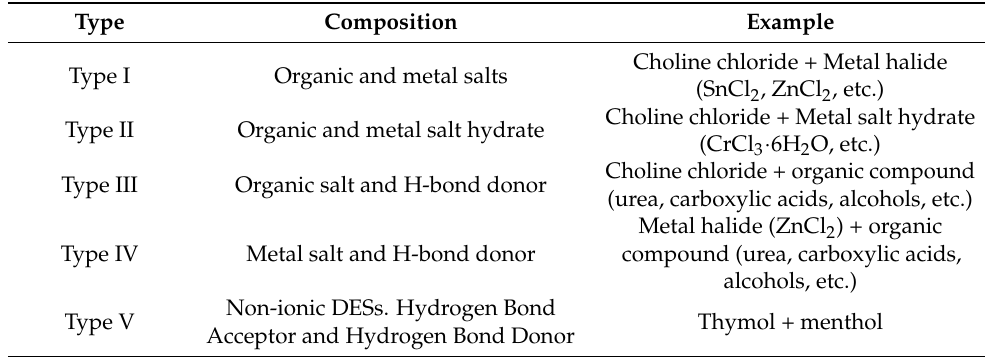
Table 1. Types of DESs, their compositions, and